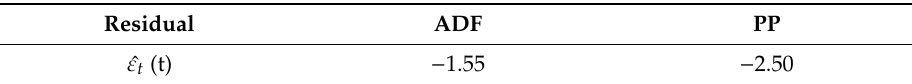
Table 5. EG cointegration test